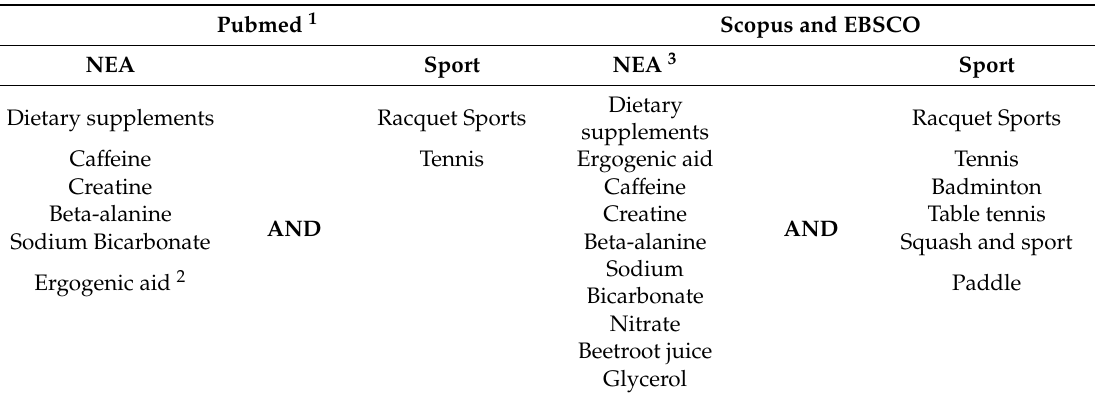
Table 1. Combined terms used in the search for studies in the database. 1 Mesh terms were used in the search; 2 Term not included in the Mesh search; 3 nutritional ergogenic aid (NEAs) filed in the A group of the Australian Institute of Sport